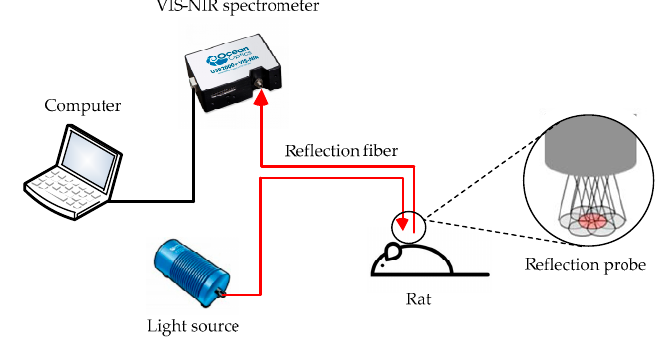
Figure 1. Reflection spectrum measurement system diagram.